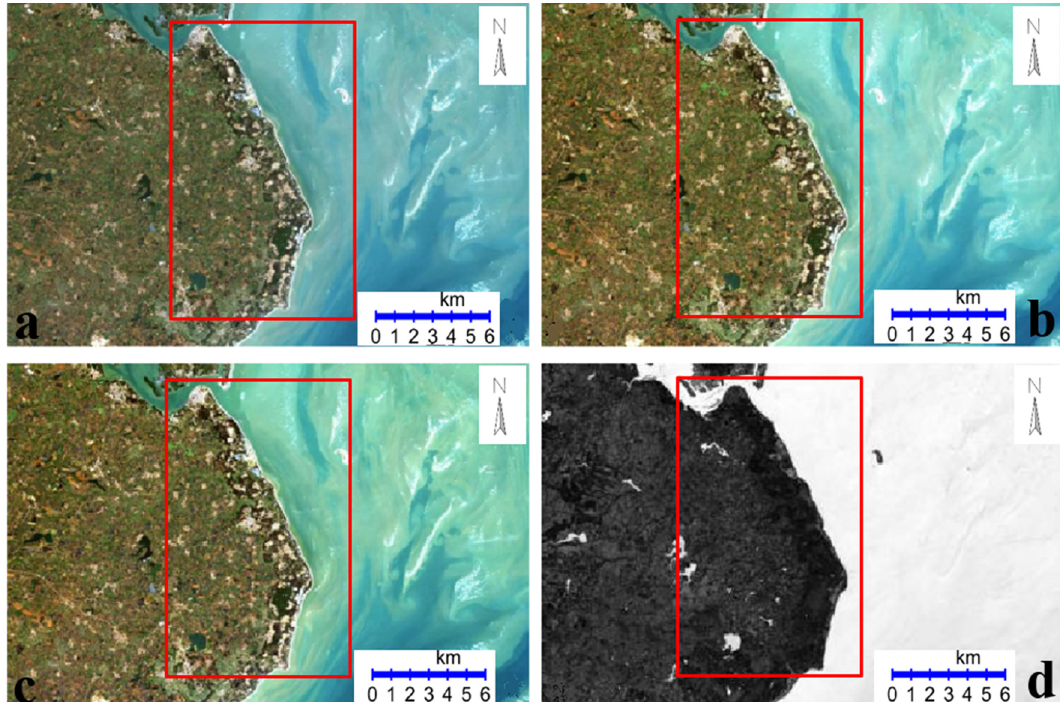
Figure 2. Image preprocessing: ( a ) original satellite image; ( b ) radiometrically corrected satellite image; ( c ) image with atmospheric correction after the radiometric correction; ( d ) image processed by the Modified Normalized Difference Water Index ( MNDWI ).